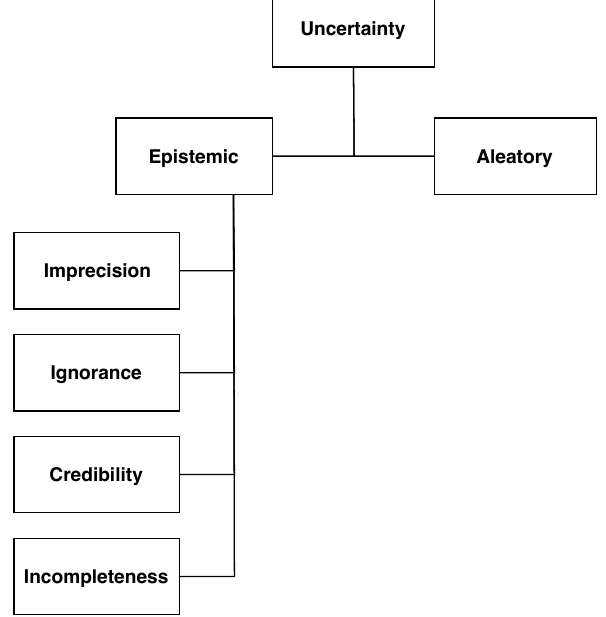
Figure 1. Fisher’s taxonomy of uncertainty [17], adapted by